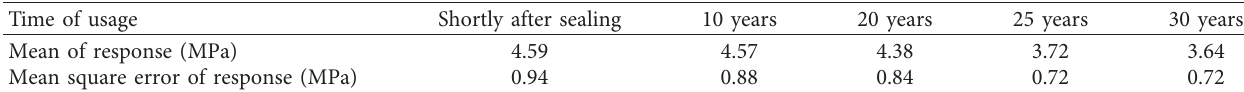
Table 4: The mean values and the mean square error in case of the maximum contact pressure after storage and aging of the sealed structure.